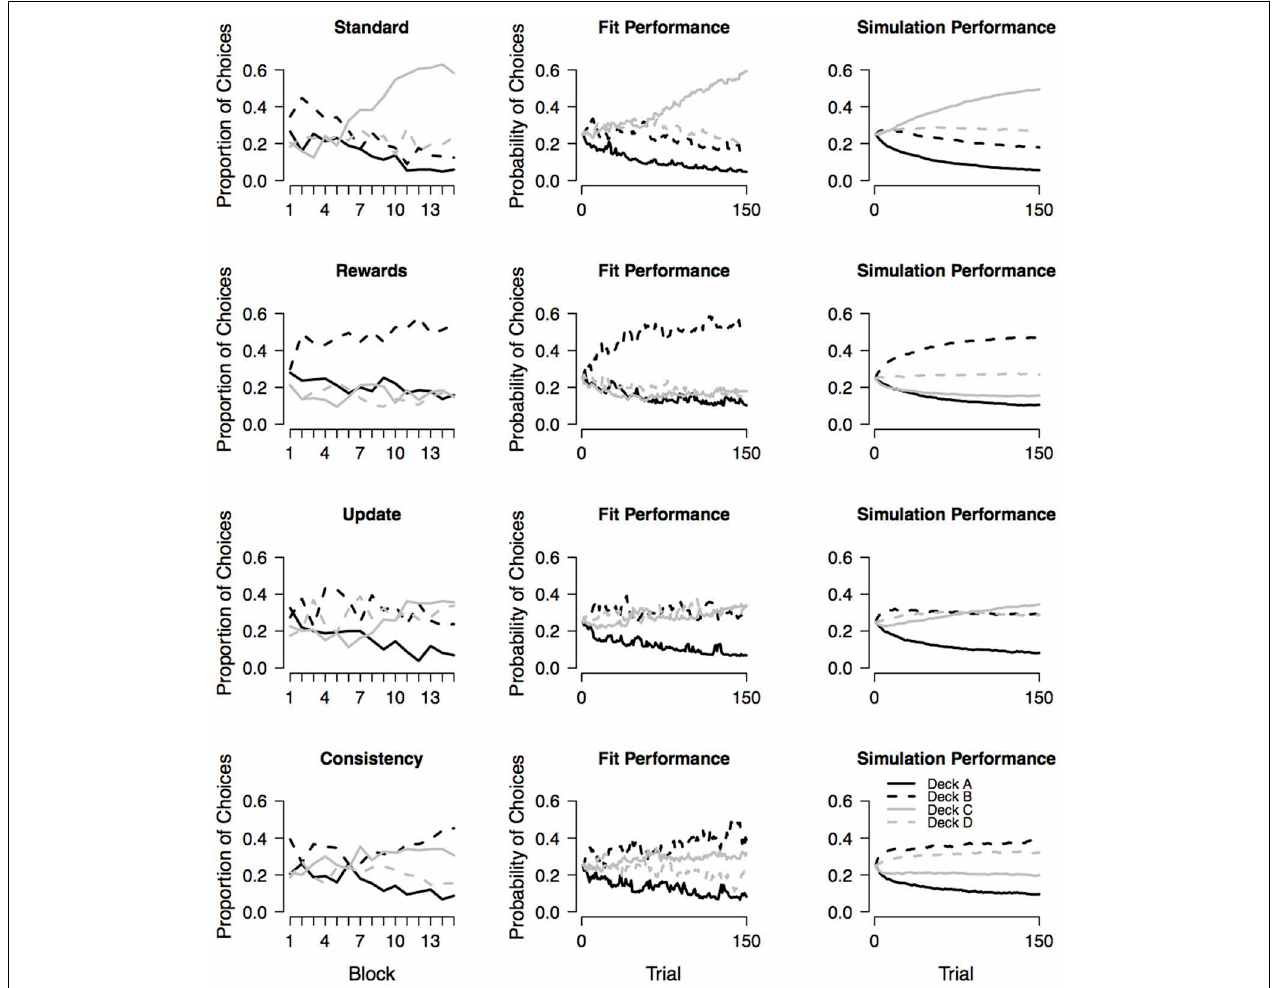
FIGURE 9 | Observed choice behavior and assessment of absolute model performance. The first column shows the mean proportion of choices from each deck within 15 blocks as observed in the four experimental conditions reported by Wetzels et al. (2010). Each block contains 10 trials. The